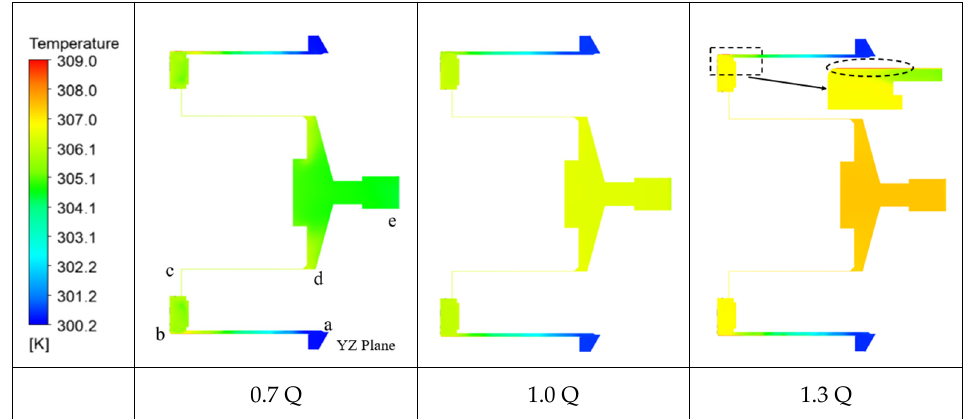
Figure 12. Temperature distribution of the cooling circuit at different flow rates.